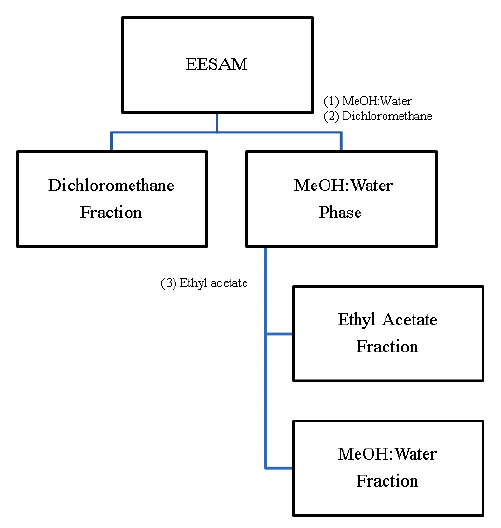
Figure 10. Proposed partition scheme. Source: Silva, 2017